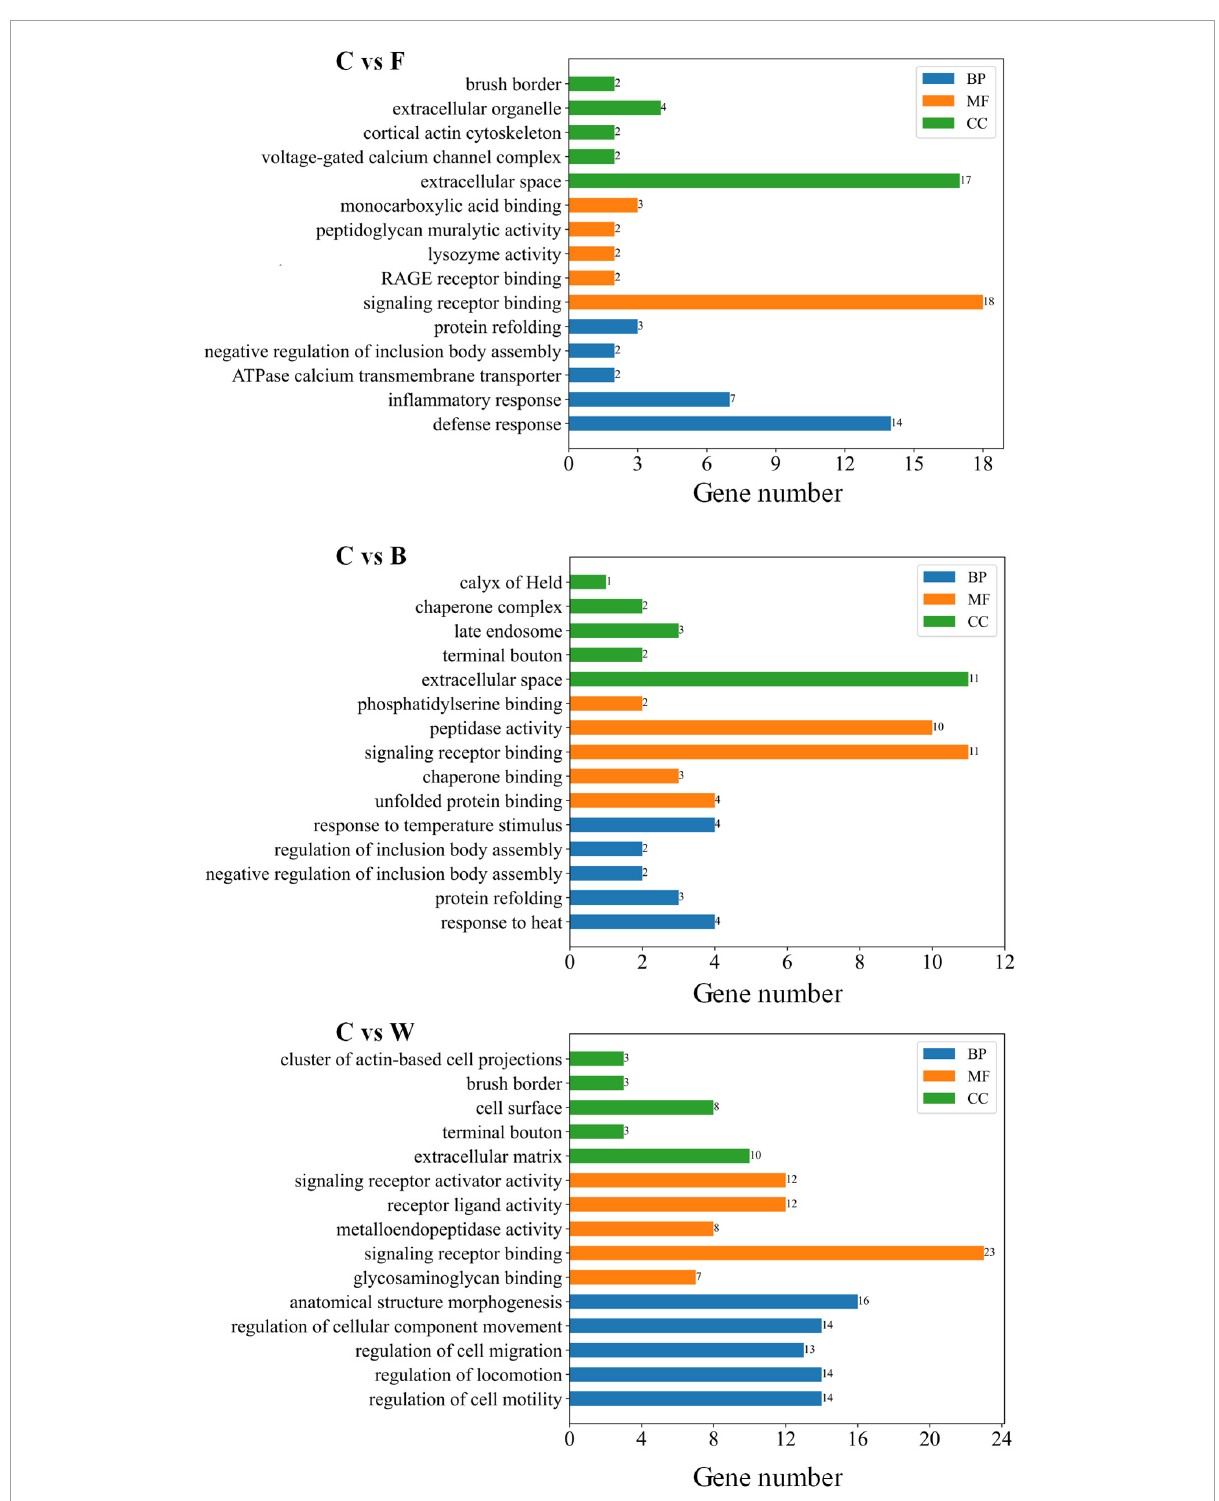
FIGURE5 Gene Ontology (GO) annotation of the differentially expressed genes (DEGs) identified between the control (group C) and each of the three experimental groups of Landes geese (i.e., groups F, B, and W) on day 90 showing the top five GO terms in each of the three categories of GO terms, including molecular function (MF), cellular component (CC), and biological process (BP). Group C, control group; Group B, added with 4% BSG in the overfeeding stage (days 61–90); Group F, added with 4% BSG in the rearing stage (days 5–60); Group W, added with 4% BSG in the all stage (days